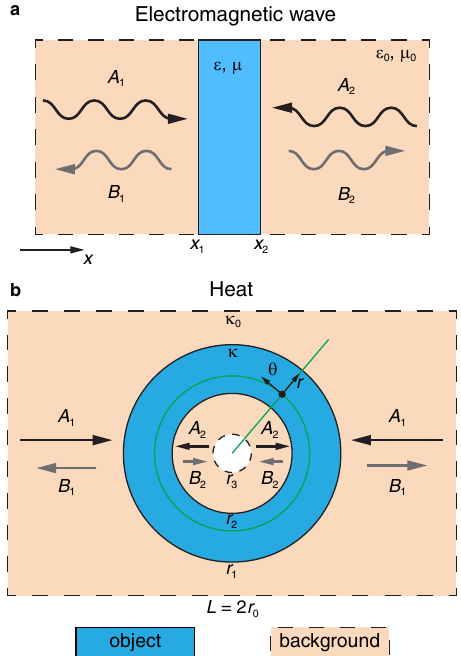
Fig. 1 Correspondence between two distinct processes. a Scattering of electromagnetic waves in one-dimension. b Steady-state heat diffusion in two-dimension. An object (light blue) is put in a background (beige). The black arrows represent incoming waves ( fi elds) with amplitudes A 1 and A 2 . The grey arrows represent outgoing waves ( fi elds) with amplitudes B 1 and B r , θ ) is built in b (green 2 . A polar coordinate system (